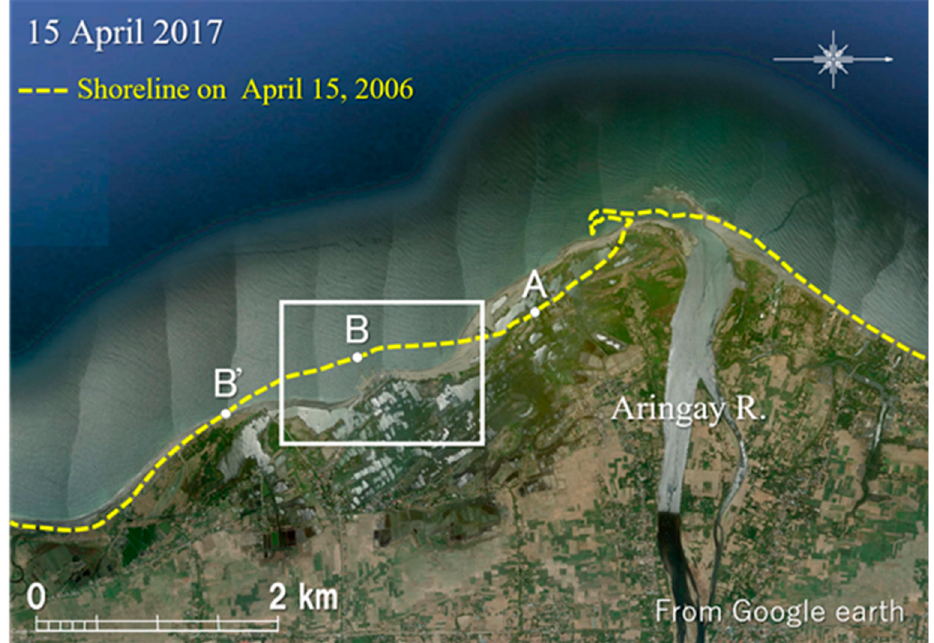
Figure 17. Satellite image of shoreline around Aringay River mouth (15 April 2017).